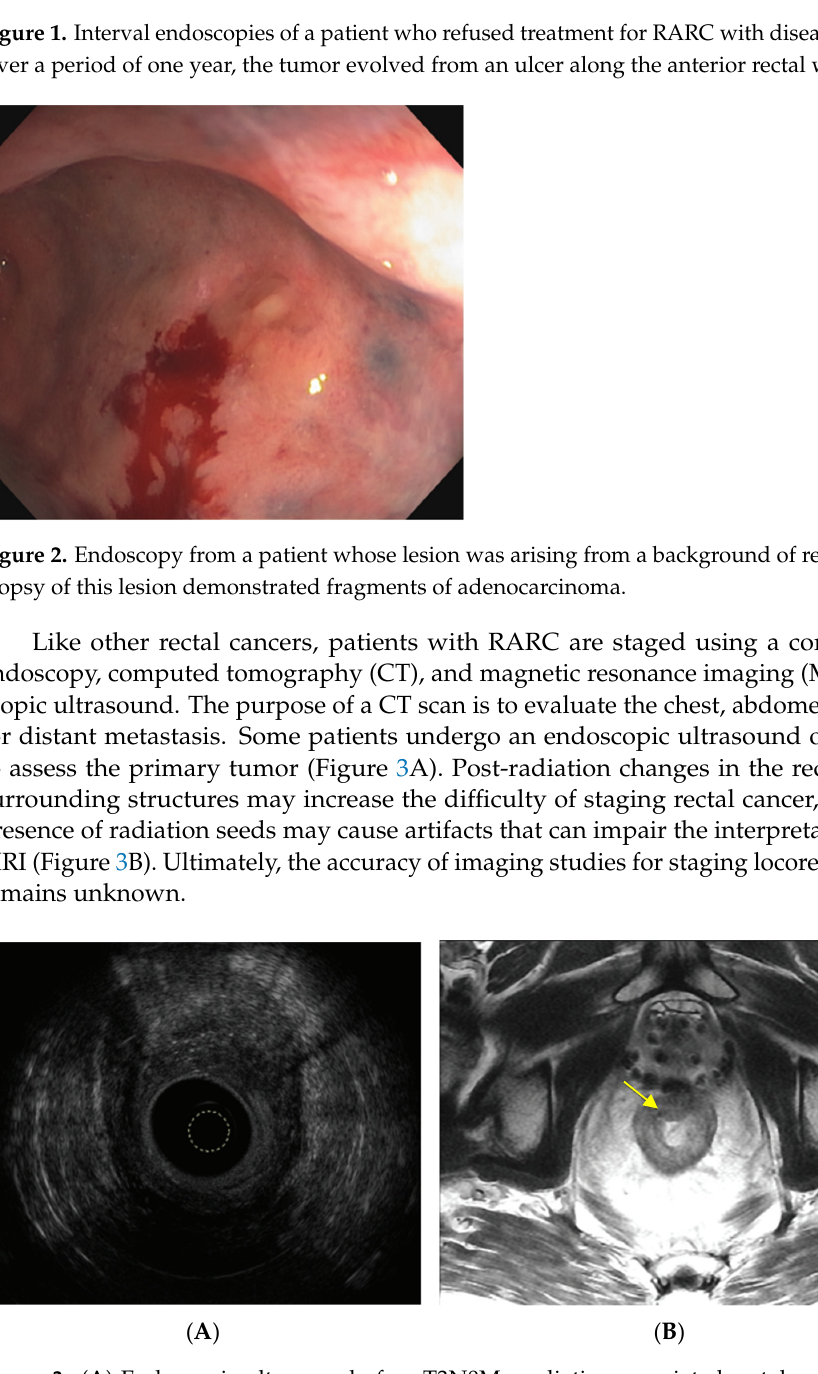
Figure 3. ( A ) Endoscopic ultrasound of a uT3N0Mx radiation-associated rectal cancer along the anterior rectal wall. The yellow circle marks the tip of the ultrasound probe. ( B ) MRI of the rectum depicting a radiation-associated rectal cancer in a patient who underwent brachytherapy for pros- tate cancer. The yellow arrow marks the